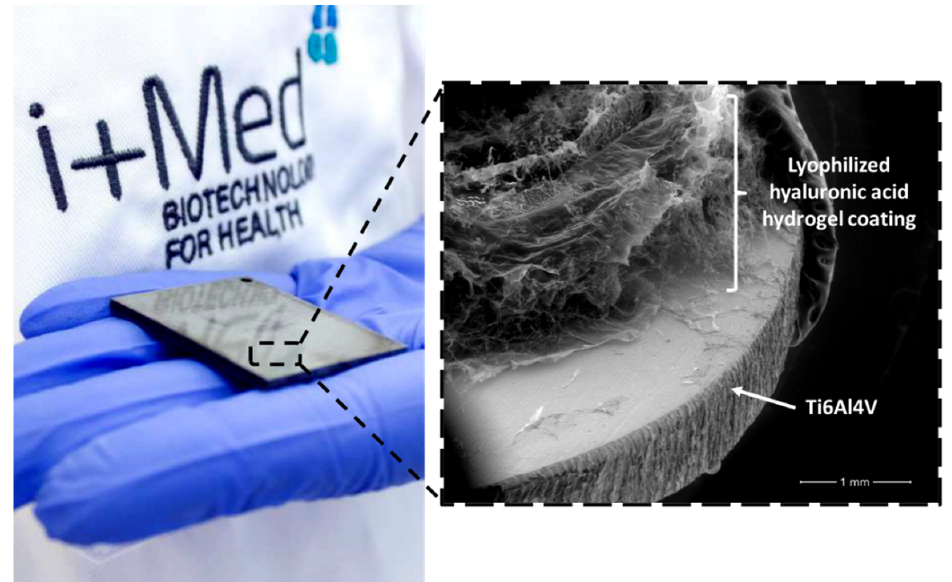
Figure 9. Example of a hyaluronic acid hydrogel coating on Ti6Al4V surface for potential active agents delivery.